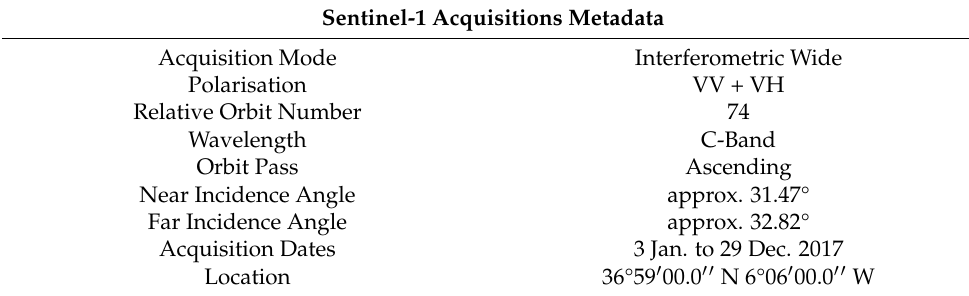
Table 1. Metadata of Sector BXII Sentinel-1 multitemporal stack.